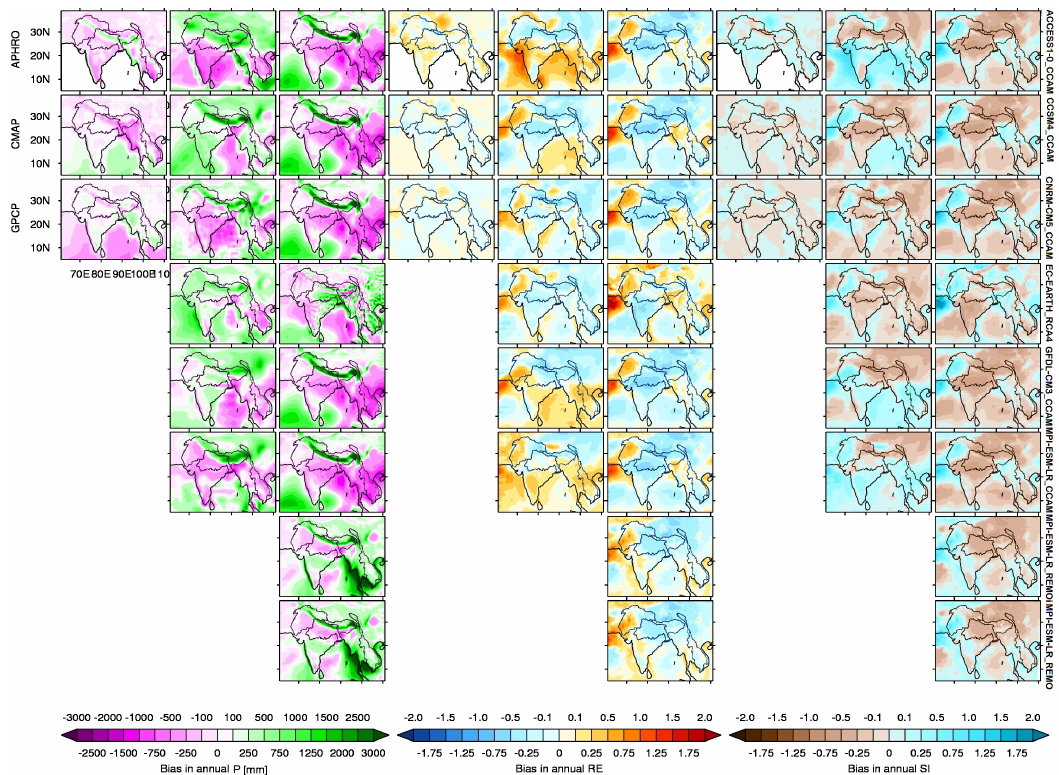
Figure 10. Same as Figure 8, but for the annual